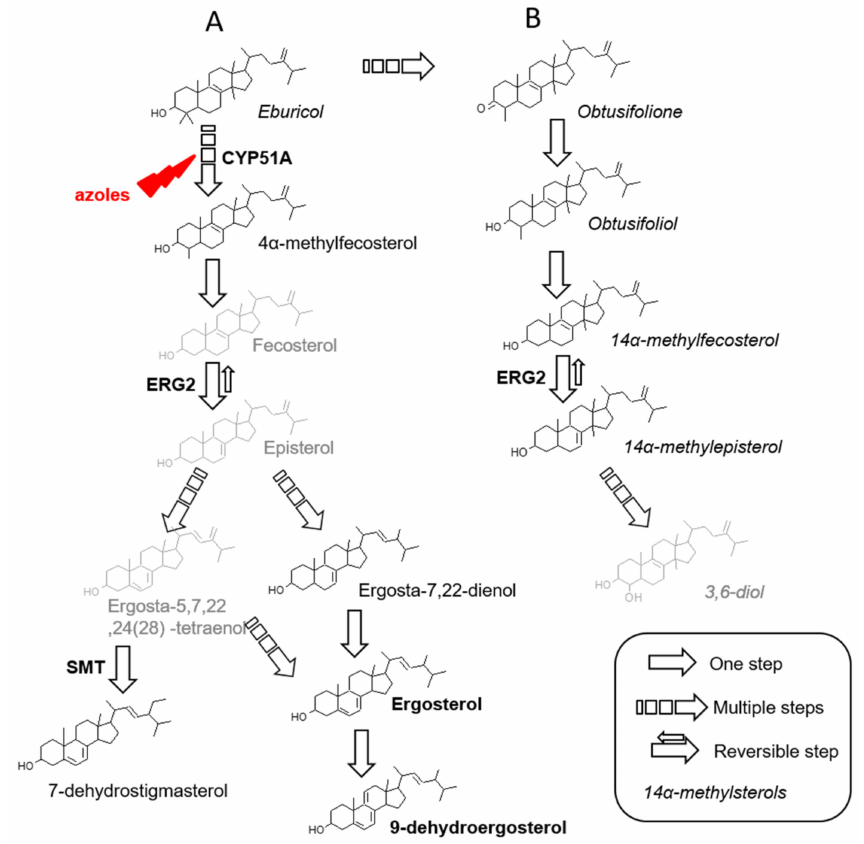
Figure 2. Aspergillus fumigatus sterol biosynthesis pathway ( A ) Possible pathway for ergosterol biosynthesis ( B ) Alternative pathway, after CYP51 inhibition. In grey sterol intermediates not detected in this study. SMT: sterol